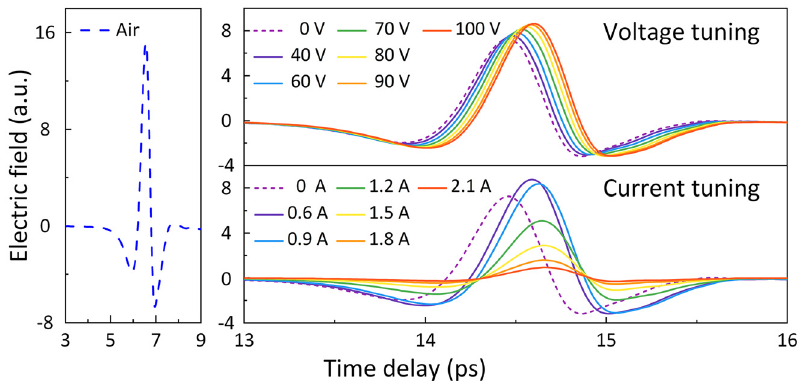
Figure2: Time-domaintransmittancesignals oftheproposeddual-modemeta-modulator and their amplitude change under different external voltage and current excitations. The signal waveform of the reference (blue dotted line) is plotted on the left